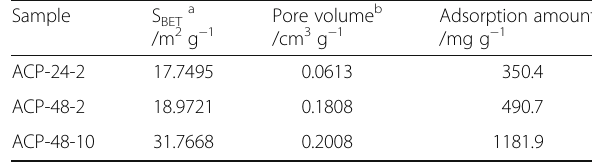
Table 1 The surface area (S BET ), pore volume, average pore size, and adsorption for samples synthesized under the different conditions